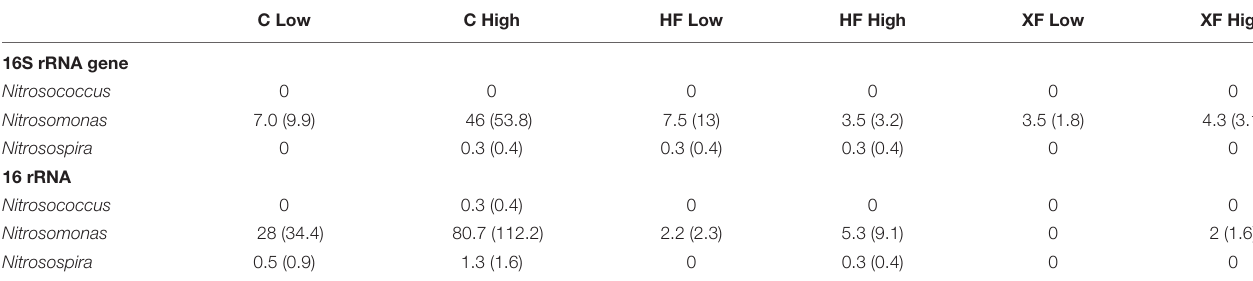
Standard deviations are in parentheses (n = 4). Note different rarefaction depths for DNA (9500 sequences per sample) and RNA (7000 sequences per sample). Numbers < 1 indicate that the taxon was found only in a subset of the